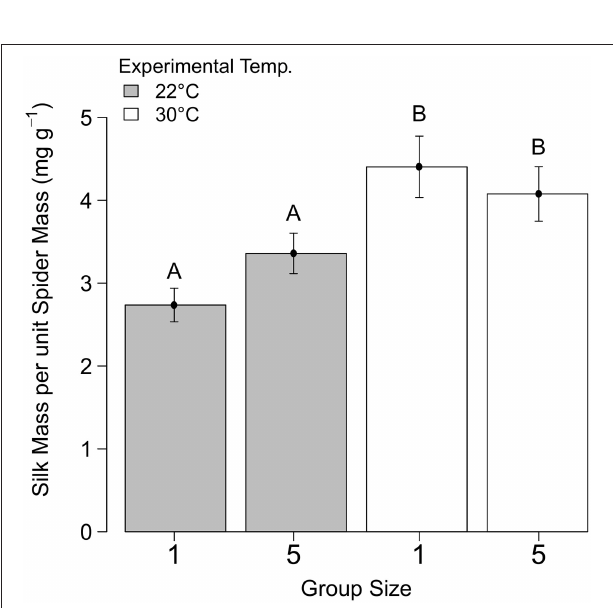
FIGURE 4 | The mean ( ± SE) silk deposition of Stegodyphus dumicola (mg) per spider (g) kept at two different group sizes (one and five) and two different temperatures (22 and 30 ◦ C) for 3 days. Letters above bars indicate significant